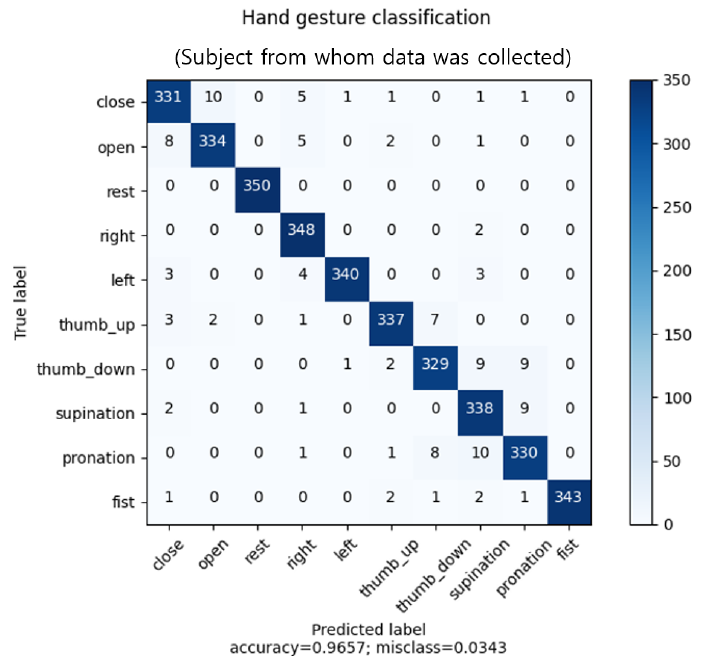
Figure 10. Confusion matrix for the subjects who participated in data